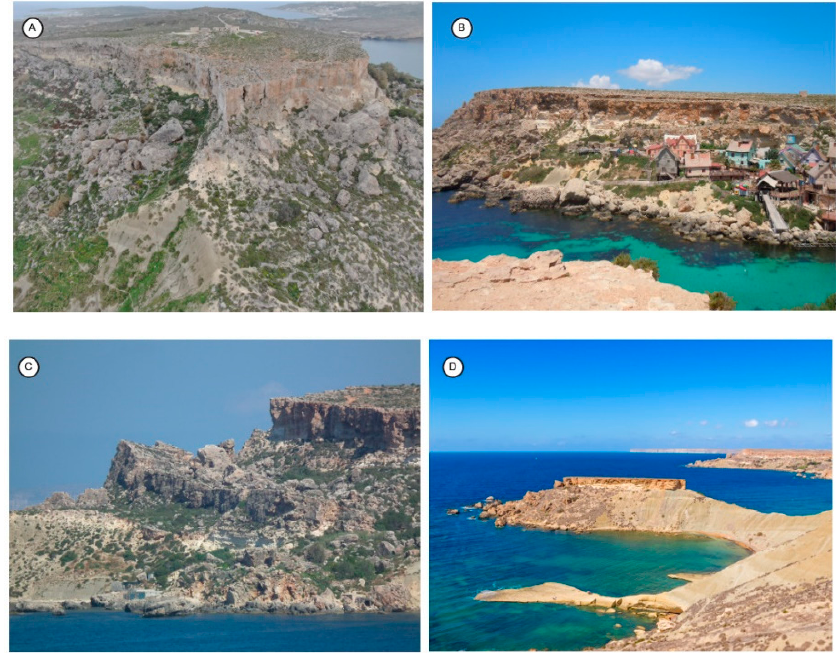
Figure 4. Views of the study sites: ( A ) Marfa Ridge; ( B ) Anchor Bay; ( C ) Ras Il-Wahx headland; and ( D ) Il-Qarraba peninsula.